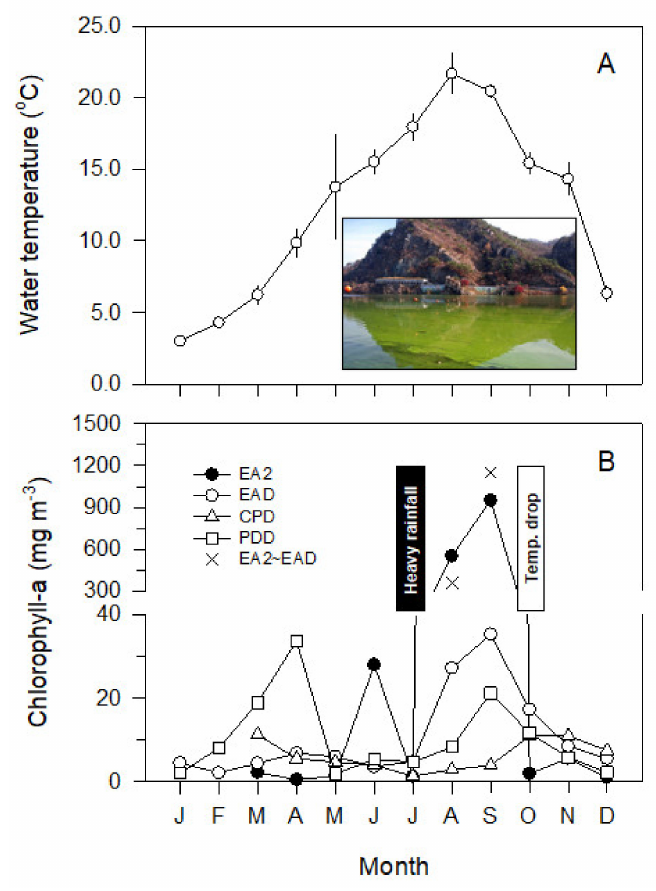
Figure 5. Spatial and temporal variations of the ( A ) chlorophyll- a concentration and ( B ) water temperature in the Euiam and Cheongpyeong Reservoirs (EAD and CPD, respectively) of the North Han River and Paldang Reservoir (PDD) of the Han River from January to December 2011. The inset photo shows massive harmful cyanobacterial bloom at the EA2–EAD site of Euiam Reservoir in September